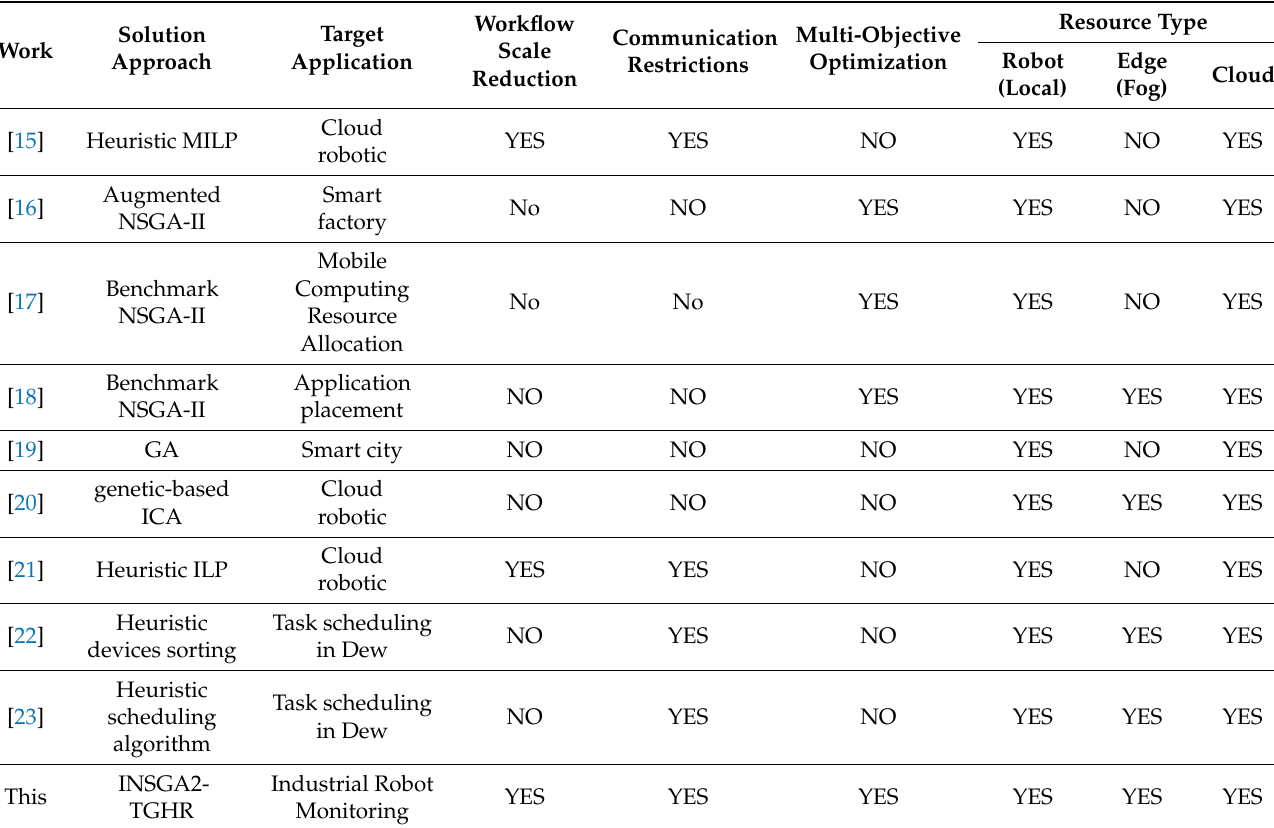
Table 1. Summary of relevant works in cloud robotics and computing resource